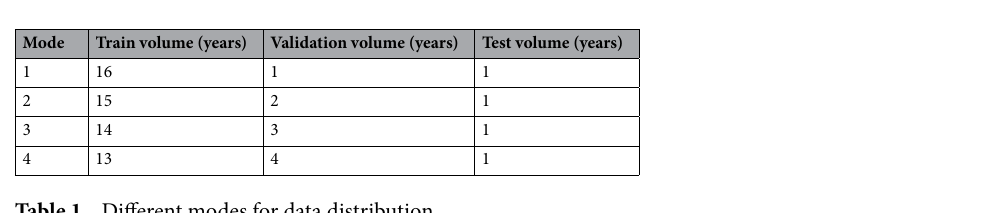
Table 1. Different modes for data